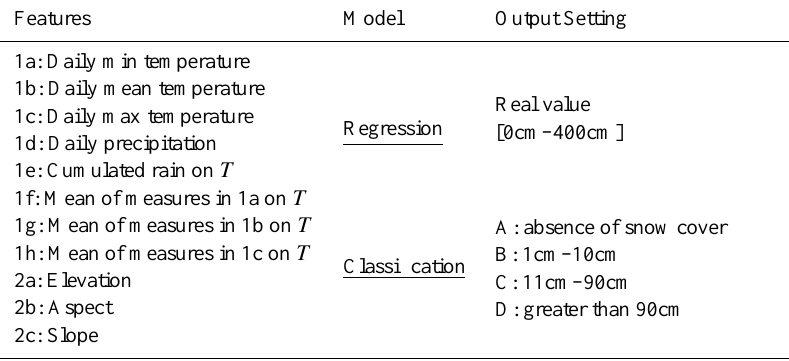
Table 1. Input and output variables used in regression and classification tasks.